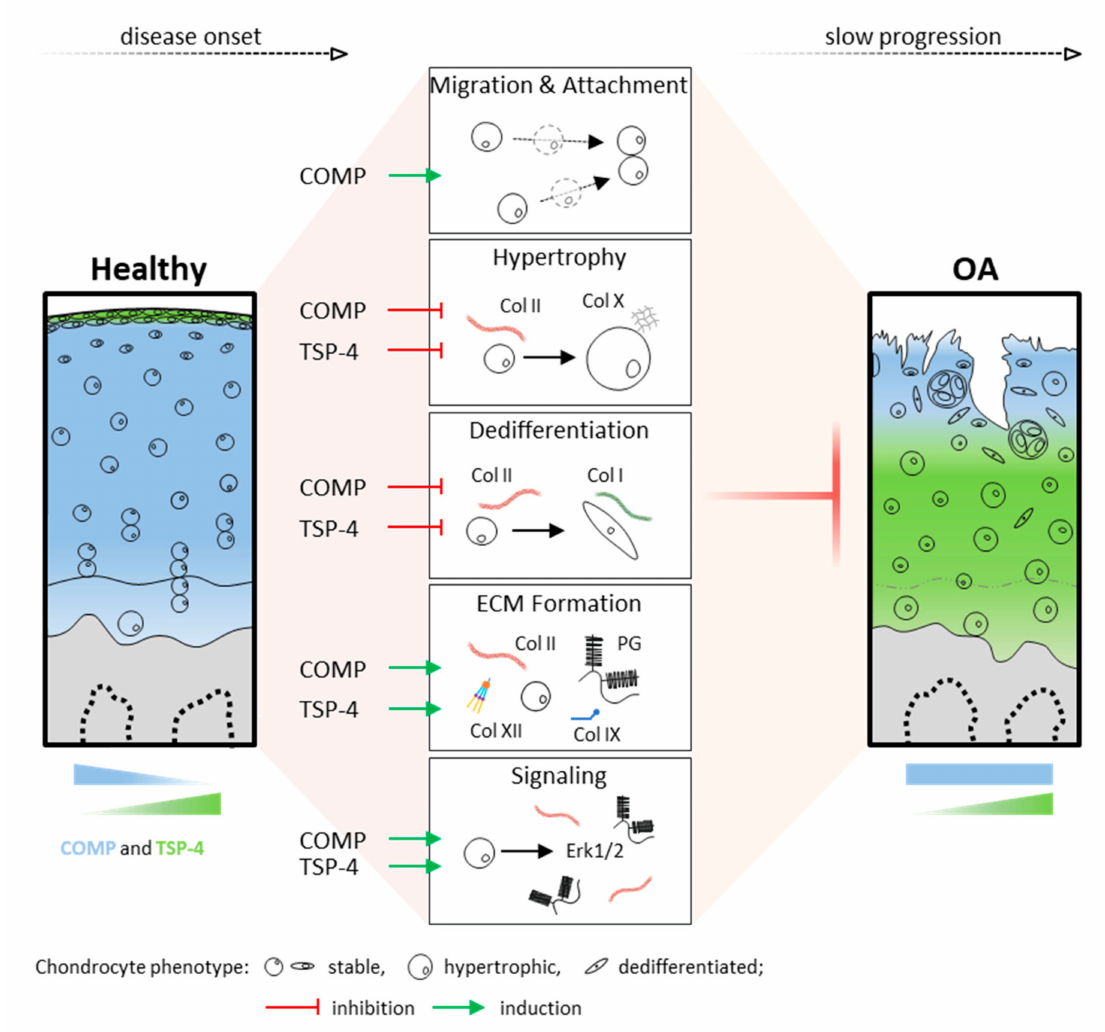
Figure 7. Functional role and distribution of COMP and TSP-4 in articular cartilage. Schematic representation of COMP and TSP-4 distribution, as well as protein levels in healthy and OA cartilage. Areas of COMP and TSP-4 expression are indicated in blue and green, respectively. Their impact on cartilage and OA relevant processes is depicted in the middle. Green arrows indicate an induction, while red T arrows mean inhibition. PG = proteoglycan and Col =